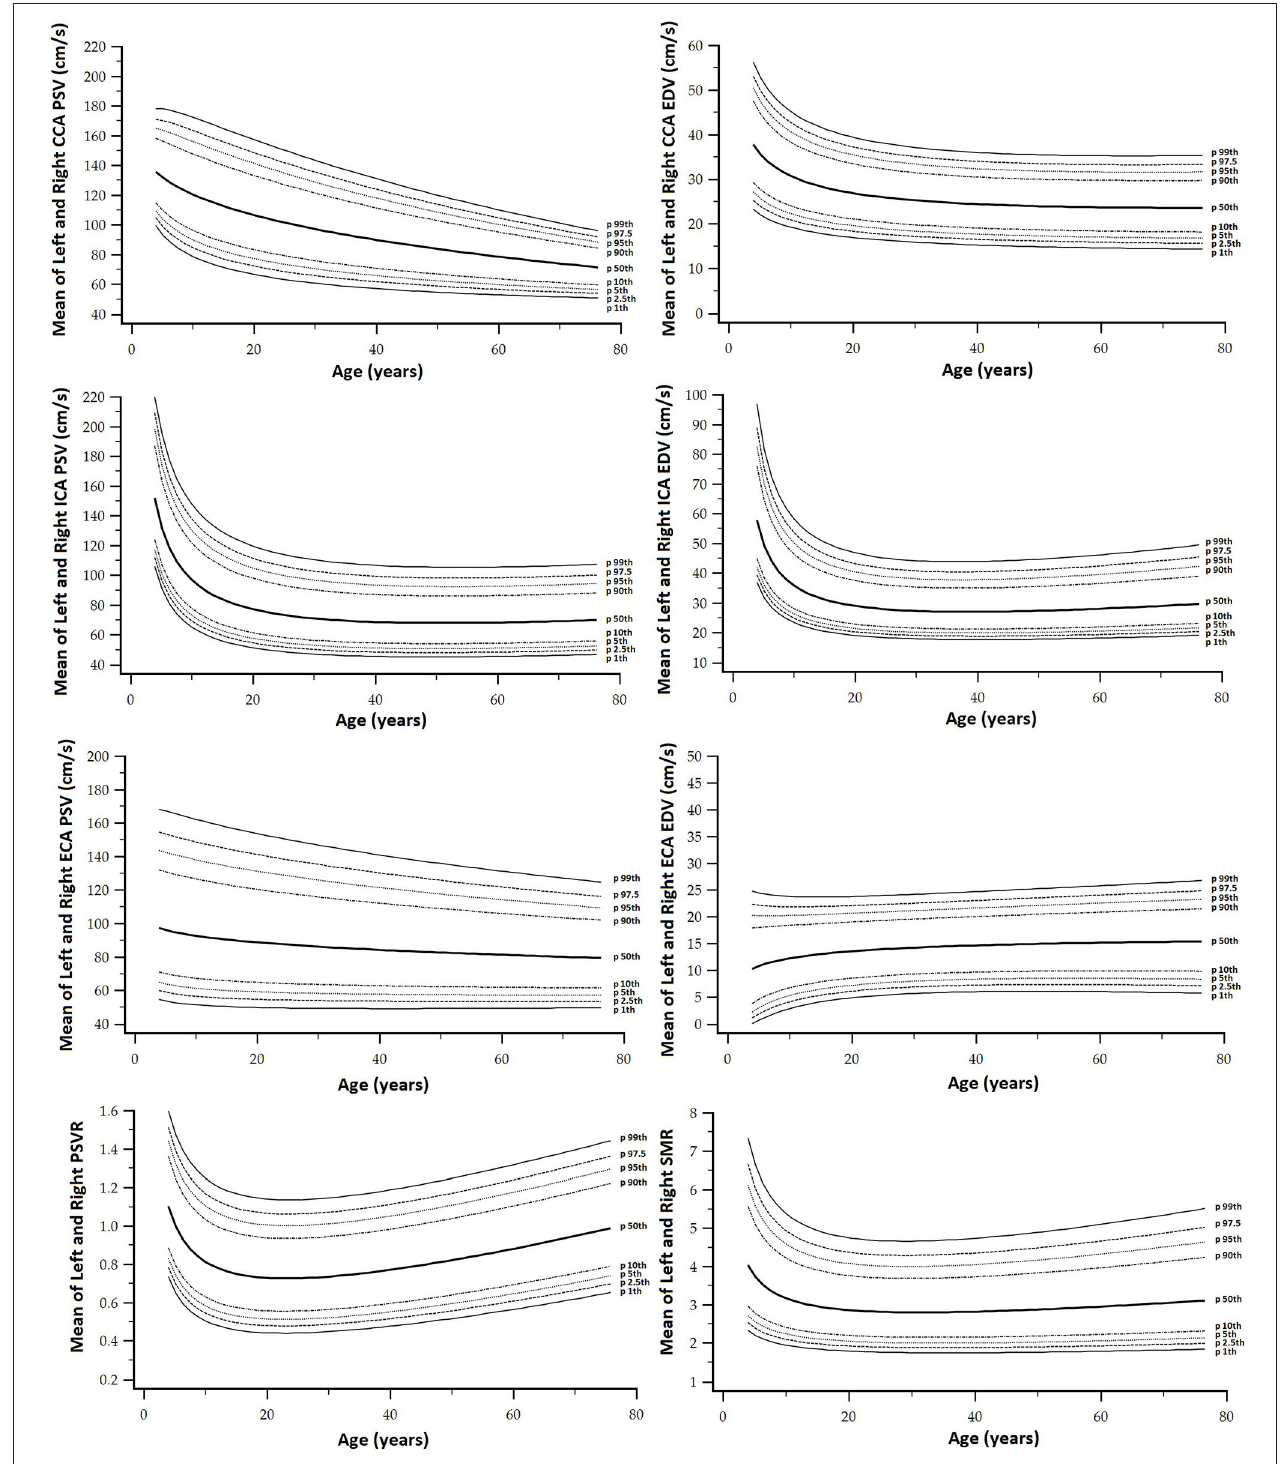
FIGURE 4 | Vertebral artery (VA), CFA, and BA PSV and EDV age-related percentile curves.